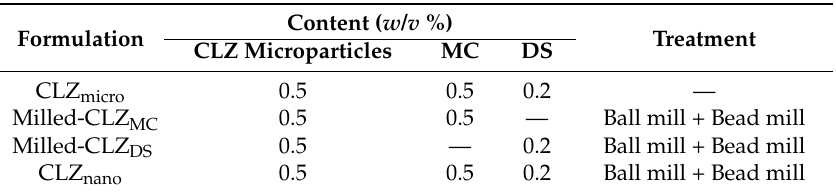
Table 1. Formulations of particle dispersions containing